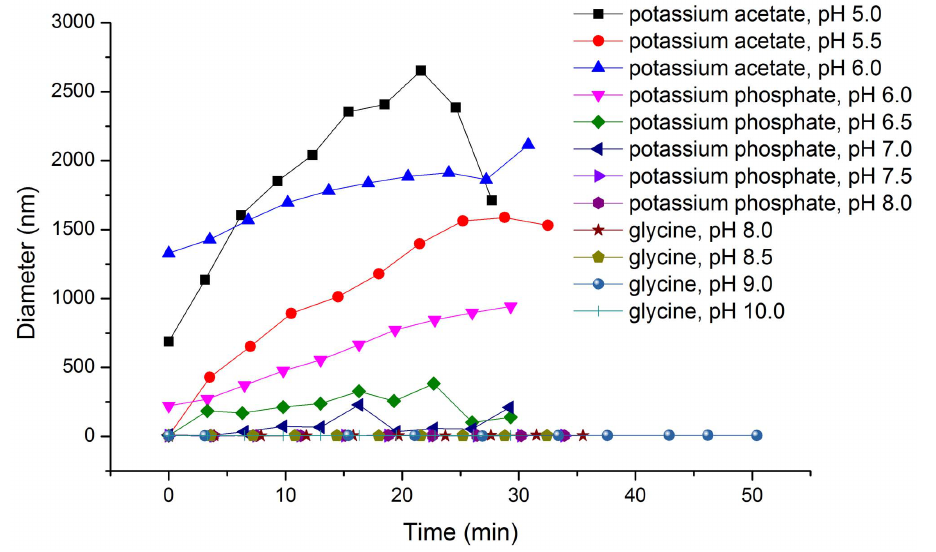
Figure 2. Time-varying particle size of DadB in different buffers. The abscissa and ordinate represent the incubation time of DadB in different buffers at 37 u C and the particle diameter,